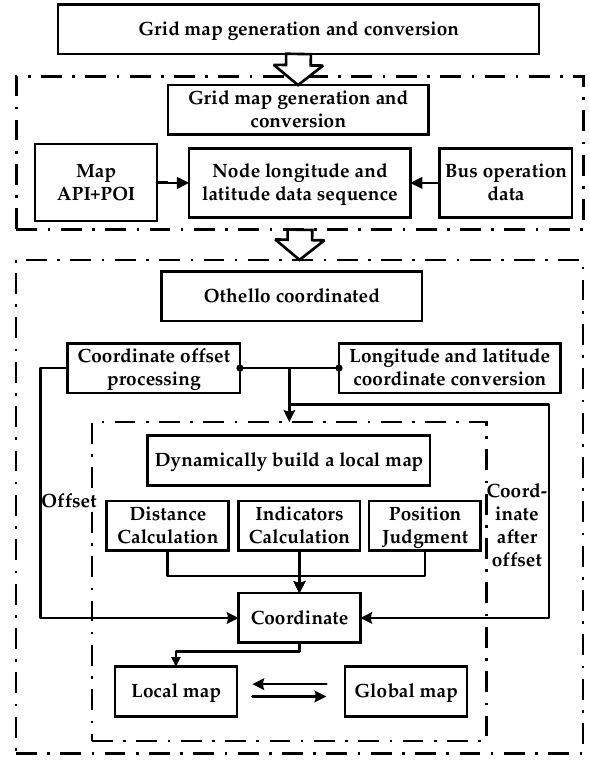
Figure 2. Flowchart of the grid map generation and conversion algorithm.